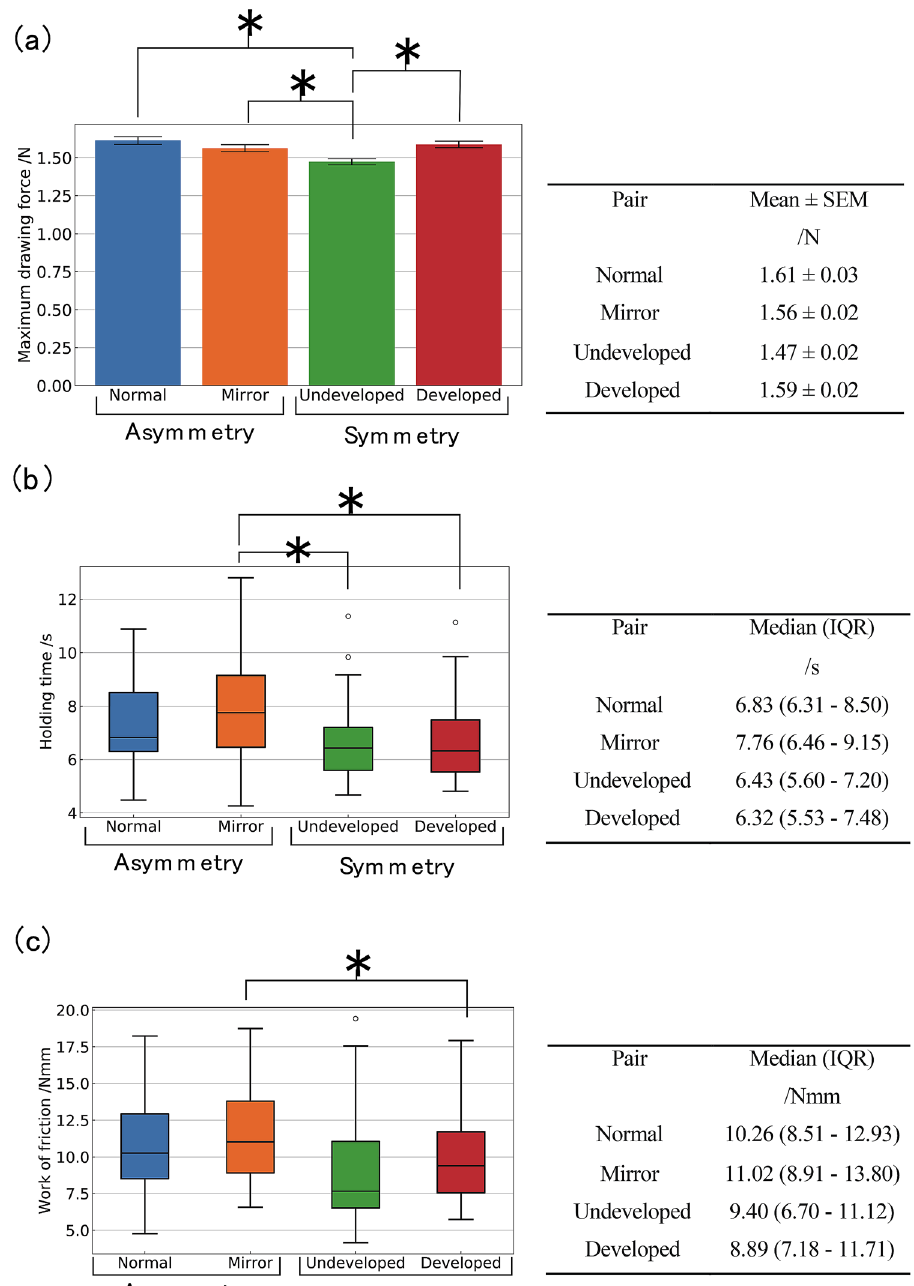
Figure 4. Mean value with a standard error and box plot of each measurement. ( a ) Maximum drawing force, ( b ) holding time, and ( c ) work of friction. Right row shows the mean values and left row shows the median